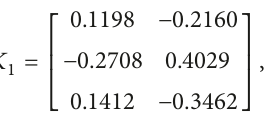
actual state responses 𝑥(𝑘) and 𝑦(𝑘) , their estimates ̂ 𝑥(𝑘) and